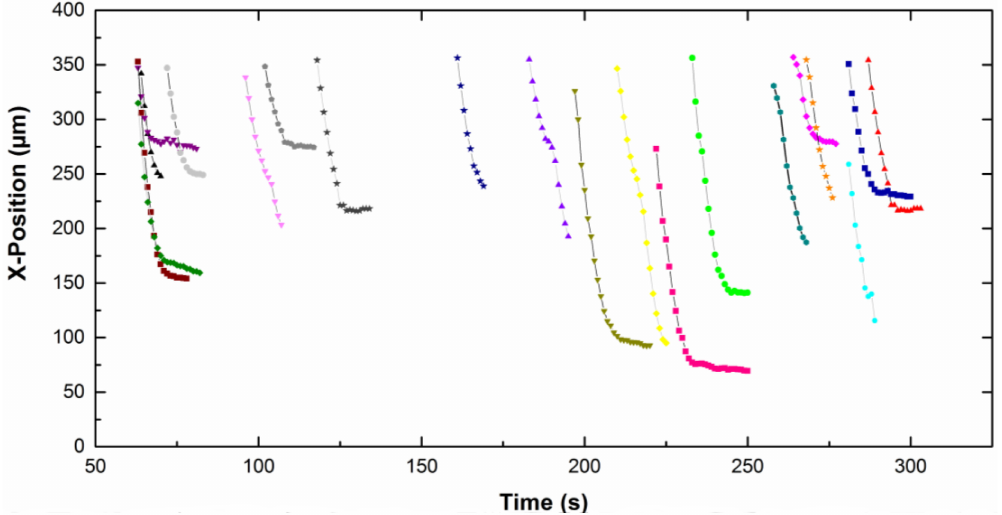
Figure 6. Particle position along the x -axis as a function of time. Particles were dispersed in 5 × 10 − 4 M CTAC solution. Each point corresponds to a measurement at a y -distance from the electrode.